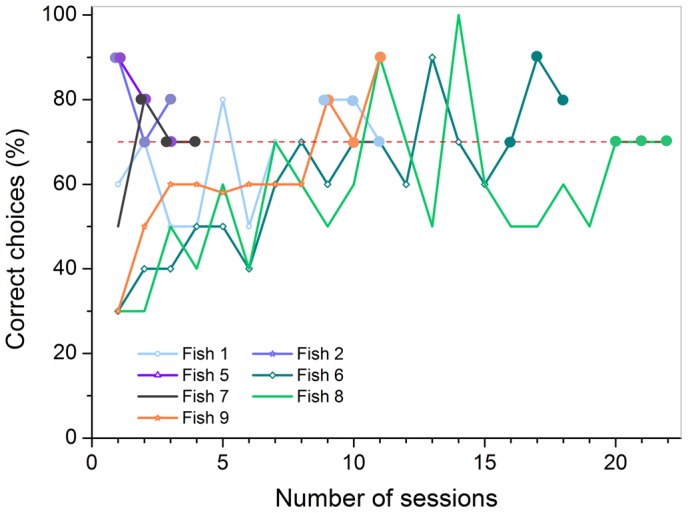
Training achievements for all individuals used in experiment 3.The colored lines display the individual learning success for each fish, shown by the percentage of correct choices per session (à 10 trials). The dashed red line indicates the threshold for the learning criterion at 70 % correct choices. The three sessions necessary to reach criterion (≥70 % correct choices) are highlighted by big dots colored analogous to the individual learning curves. If two or more dots fall together at one session, they are shown overlapping each other.